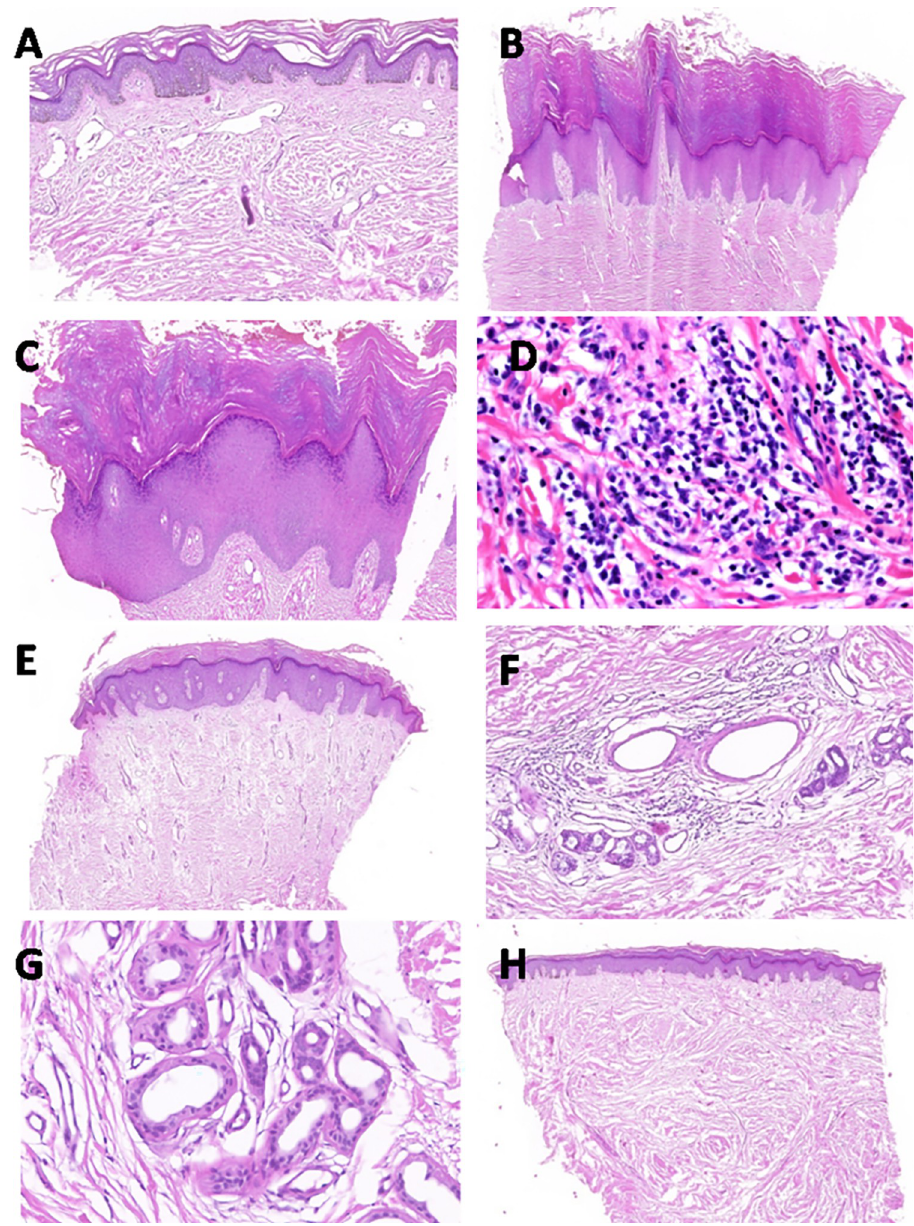
Fig 3. Histopathologic characteristics of podoconiosis in skin biopsies from 65 patients with stages 1 & 2 versus stages 3–5 podoconiosis, in Durbete Podoconiosis Prevention and Treatment Centre, Durbete, Ethiopia, February 2018 to October 2019. A) Stages 1 podoconiosis: Basket woven hyperkeratosis, acanthosis, and ectatic and dilated lymphatic vessels (40X magnification). B) Stages 2 podoconiosis: Compact hyperkeratosis and acanthosis with elongated rete ridges, sclerosis with numerous linear, perpendicular arranged capillaries in the papillary dermis (20X magnification). C) Stages 3 podoconiosis: Verrucous hyperplasia of the epidermis (40X magnification). D) Stage 3 and 4 podoconiosis: Dense dermal infiltrate with lymphocyte, histocyte and plasma cells (100X magnification). E) Stage 3 podoconiosis: Compact hyperkeratosis and acanthotic epidermis with increased dermal vasculature (20X magnification). F) Stage 4 podoconiosis: Sclerosis vessel with perivascular infiltrate (100X magnification). G) Stage 4 podoconiosis: Dilated eccrine gland with area of sclerosis around the gland (100X magnification). H) Stage 5 podoconiosis: Sclerosis dermis (both papillary and reticular) with loss of adenexal structure and vasculatures (20X magnification).